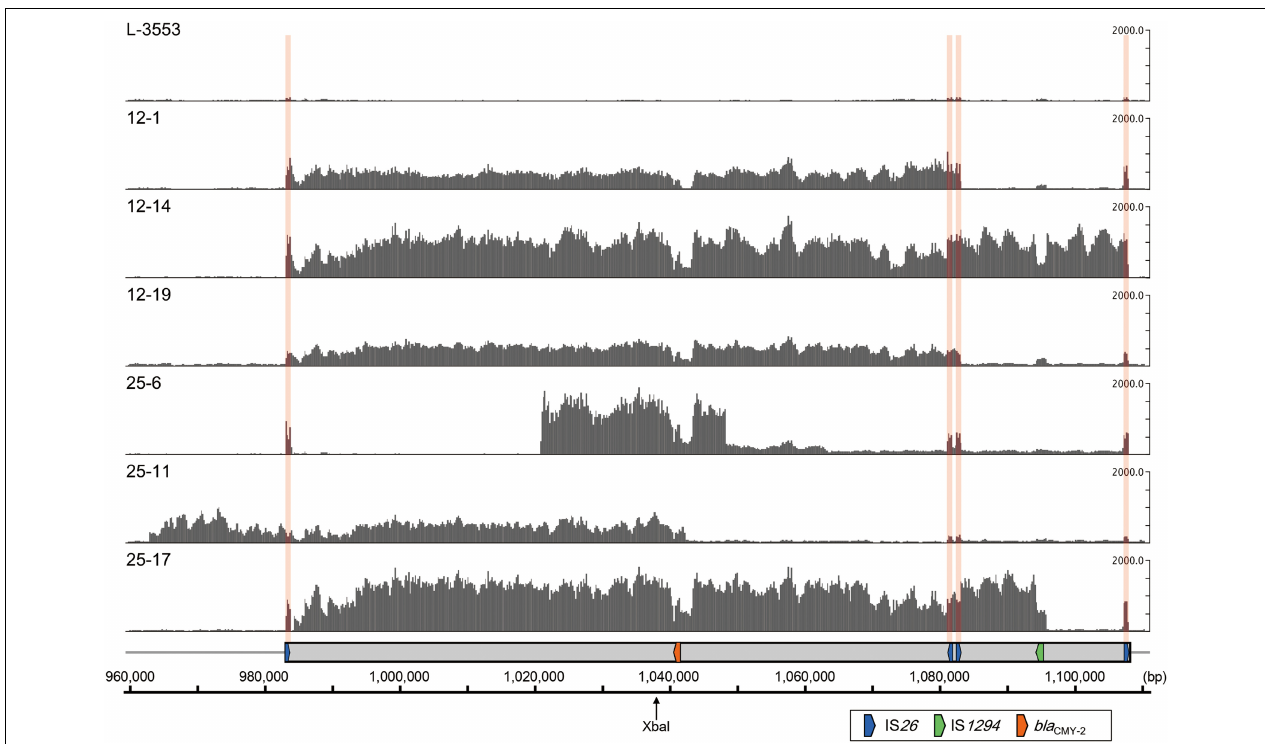
FIGURE 5 | Coverage of short-reads obtained from S . Typhimurium L-3553 and the six mutants (DDBJ Sequence Read Archive; accession number DRA001681) on the GI-VII-6 sequence of strain L-3553 (DDBJ accession number AP014565). In each row, the y-axis shows the coverage of the short-reads. The ruler at the bottom indicates the nucleotide number in the chromosome of strain L-3553.